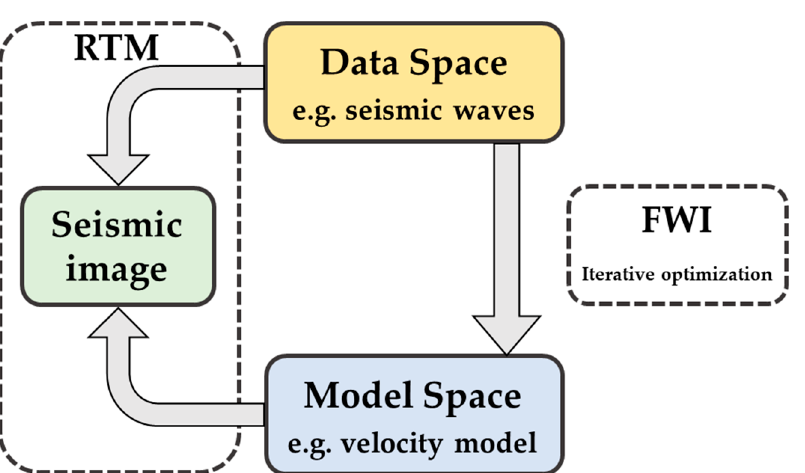
Figure 1. Schematic process of seismic imaging between data and model space using FWI and RTM.